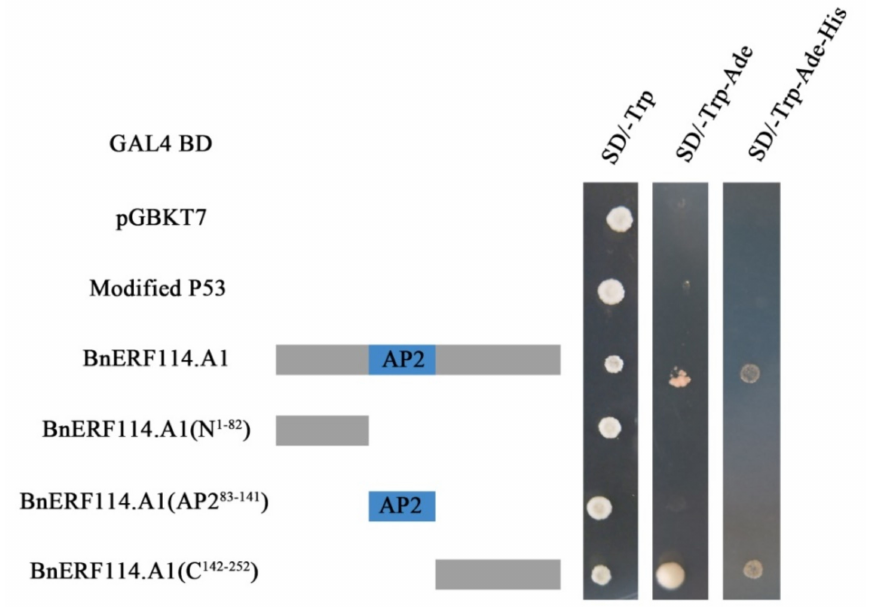
Figure 4. Transcriptional activity and functional region of BnERF114.A1 tested by yeast system. GAL4 BD indicates that Modified P53 (a modified P53 protein only containing DNA binding domain), intact BnERF114.A1, and truncated BnERF114.A1 were separately fused with GAL4 BD. pGBKT7 is empty vector used as a control. Modified P53 is used as a negative